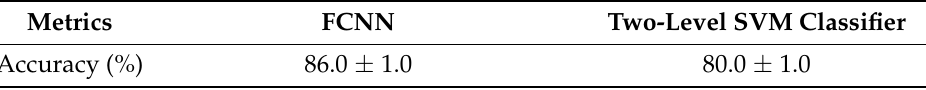
Table 2. Grading accuracy comparison of the proposed approach compared with two-level classifier. Here, FCNN and SVM stand for fully connected neural network and support vector machine, respec-